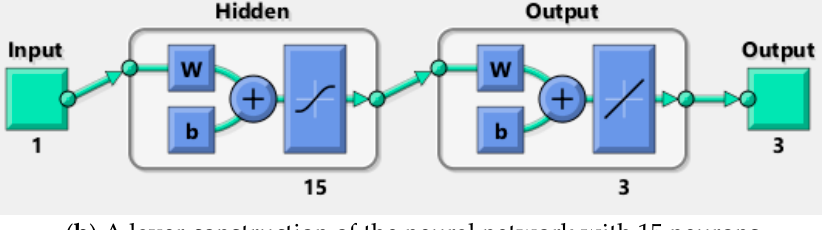
Figure 2. A neural network structure to solve the monkeypox infection system.